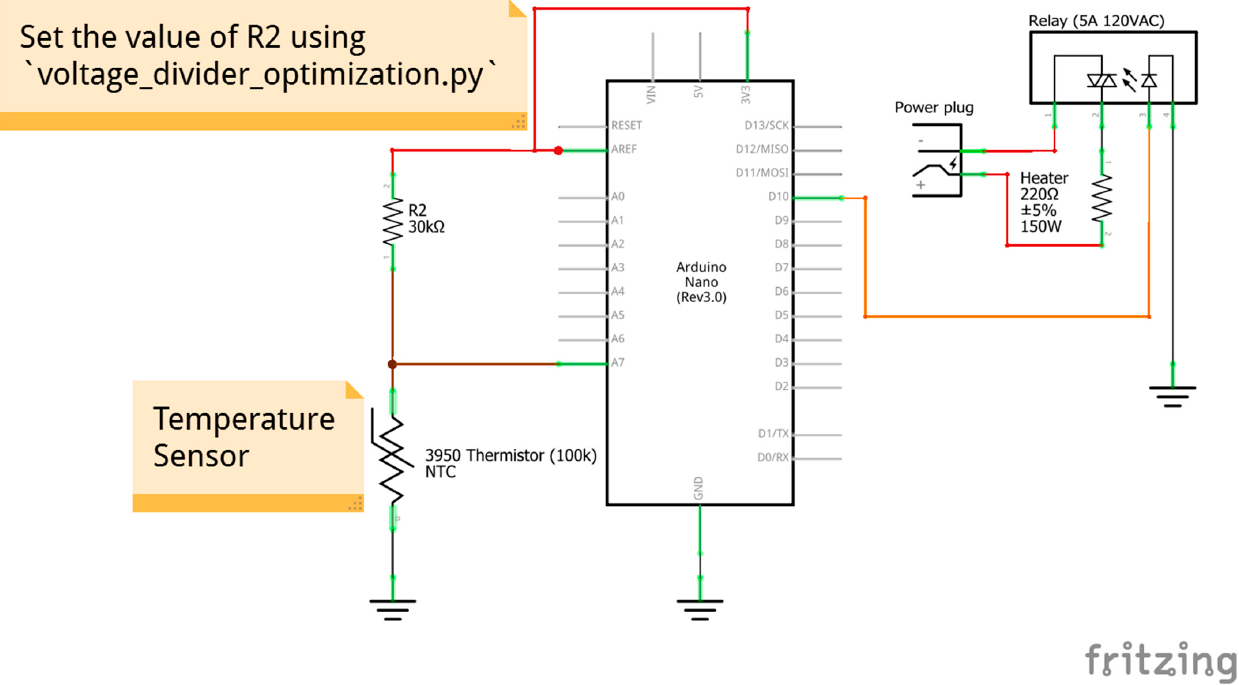
Figure 8. The circuit is a voltage divider and a pair of signal wires to control the relay. The circuit was assembled on a 3 × 7 cm solder breadboard. The assembly of that board is detailed in Appendix C, and the final circuit is shown in Figure 9.